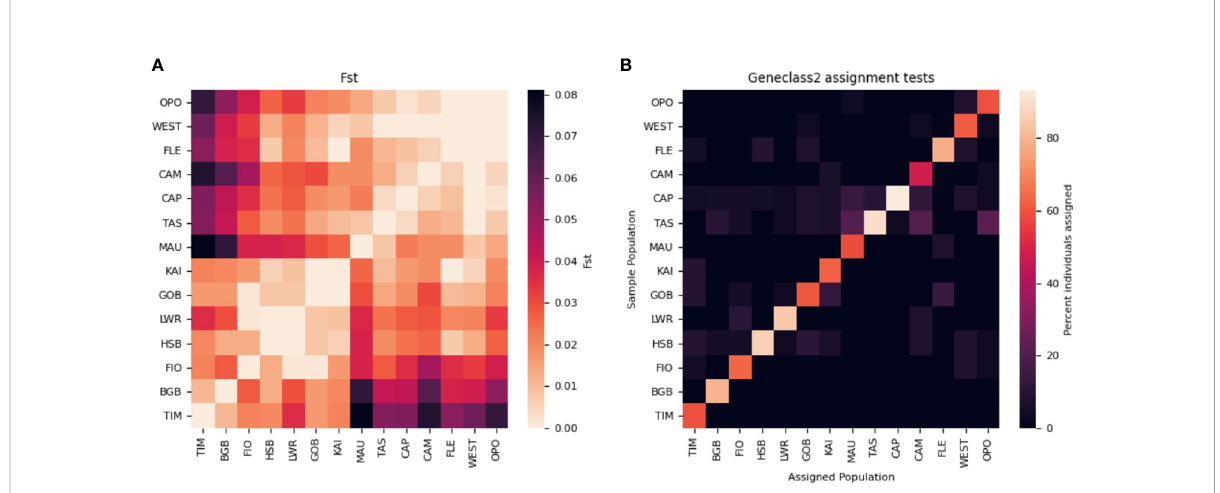
FIGURE 2 Matrices of genetic connectivity: (A) Pairwise F ST and (B) assignment tests of individuals. Populations are ordered along the axes according to UPGMA tree analyses performed in Wei et al.